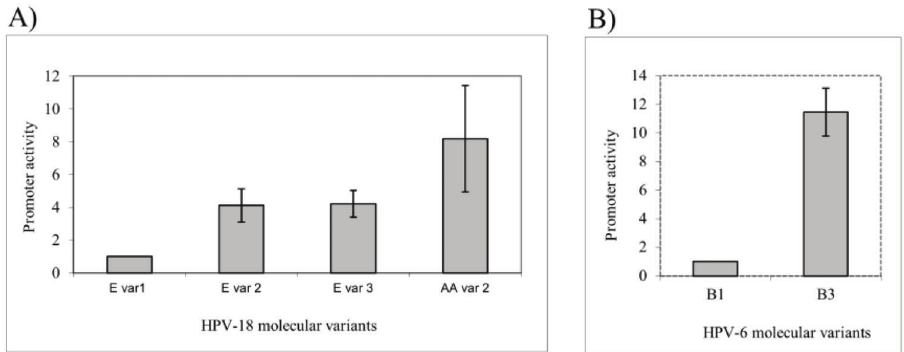
Figure 2 - Differential promoter activity among different HPV variants. (A) Variants from the HPV-18 Asian-Amerindian branch presented a higher early promoter activity than variants of the European branch. (B) For HPV-6, a variant of the B1 sublineage was ten times more transcriptionally active than was a variant from the B3 sublineage.Adapted from Sichero et al., 2005 (84) and Measso do Bonfim et al., 2015